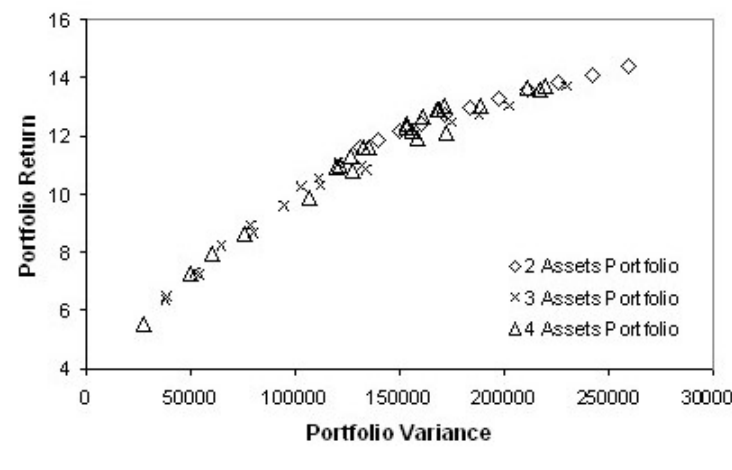
Fig. 6. Portfolio return and variance values for two (D+ and Cp) , three (D+, Cp and Fp) and all four assets portfolios under the current climate